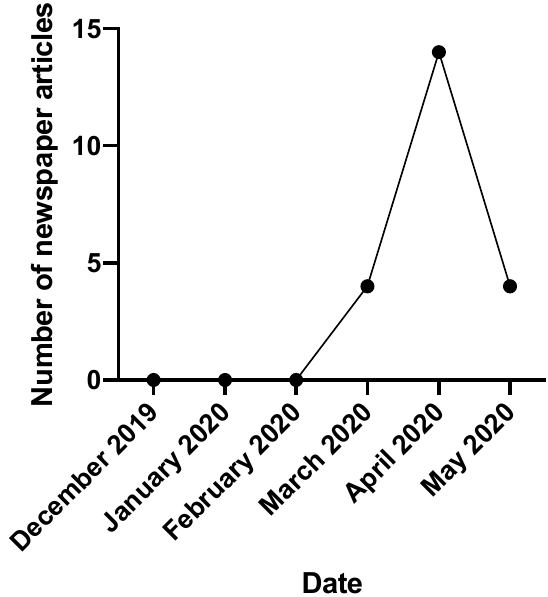
Figure 2. Number of newspaper articles published on vitamin supplementation in COVID-19 over time.